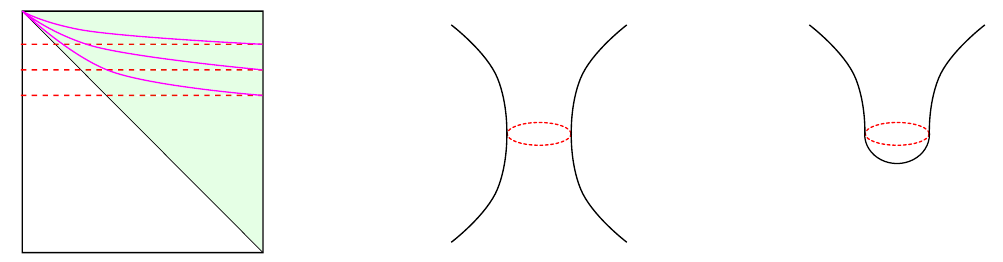
Figure 1 . Left : Penrose diagram of dS, the expanding Poincaré patch is indicated in green. Constant global (red) and Poincaré (purple) slices are also indicated. Middle: global dS. Right : no-boundary state geometry in which contracting part of the global dS is analytically continued to become a